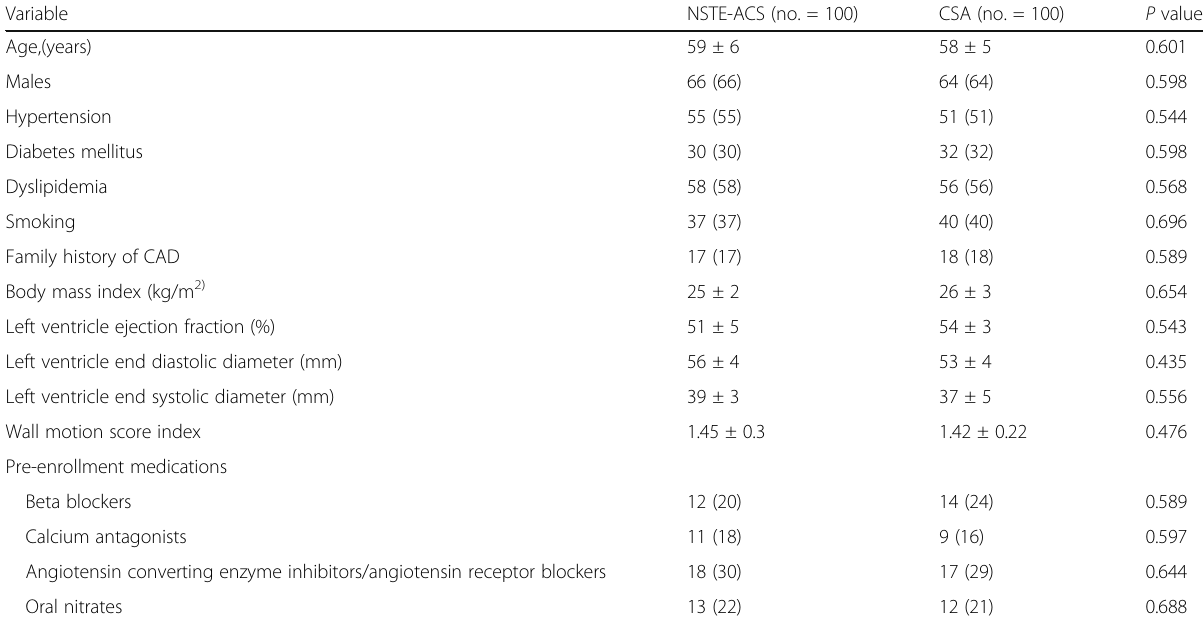
Table 1 Baseline characteristics of the two study groups